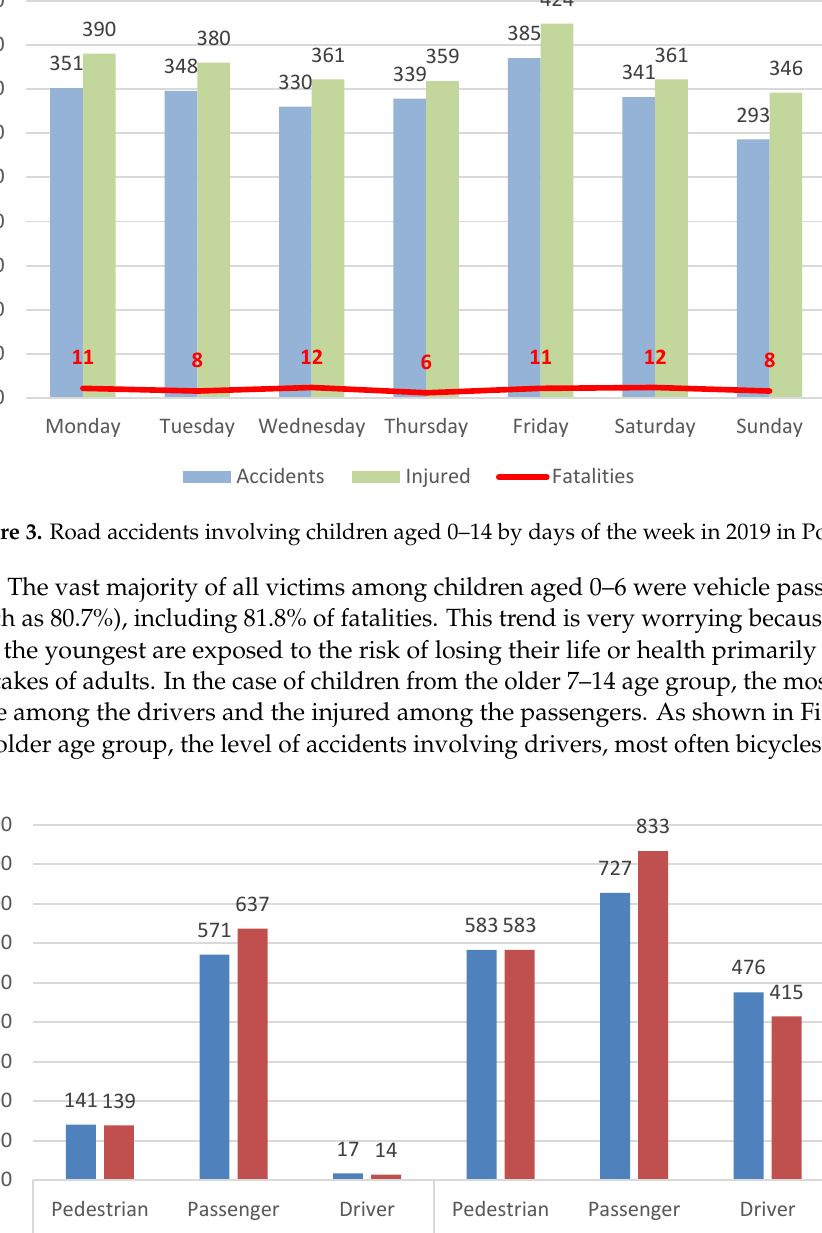
Figure 2. Road accidents involving children aged 0 – 14 in 2019 in Poland.